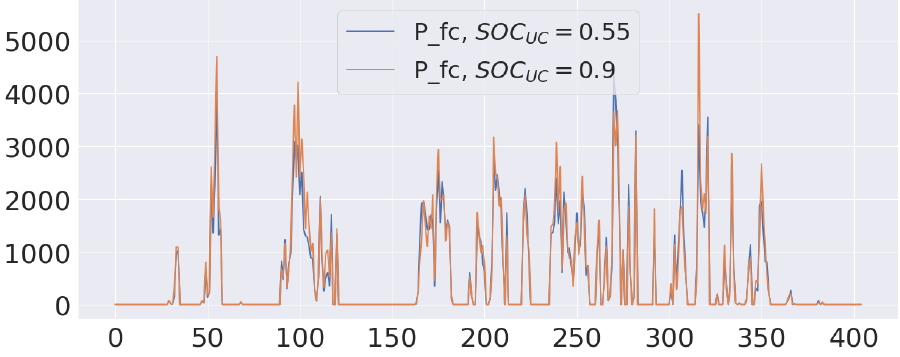
Figure 15. FC powers for different initial SOC UC for the RDC1.